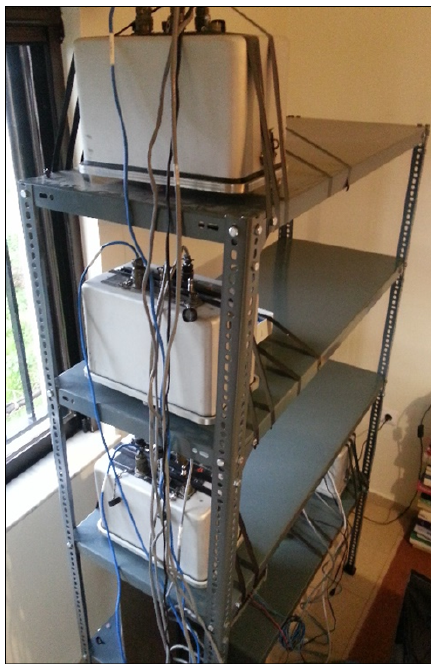
Figure 25. Metallic Dexion